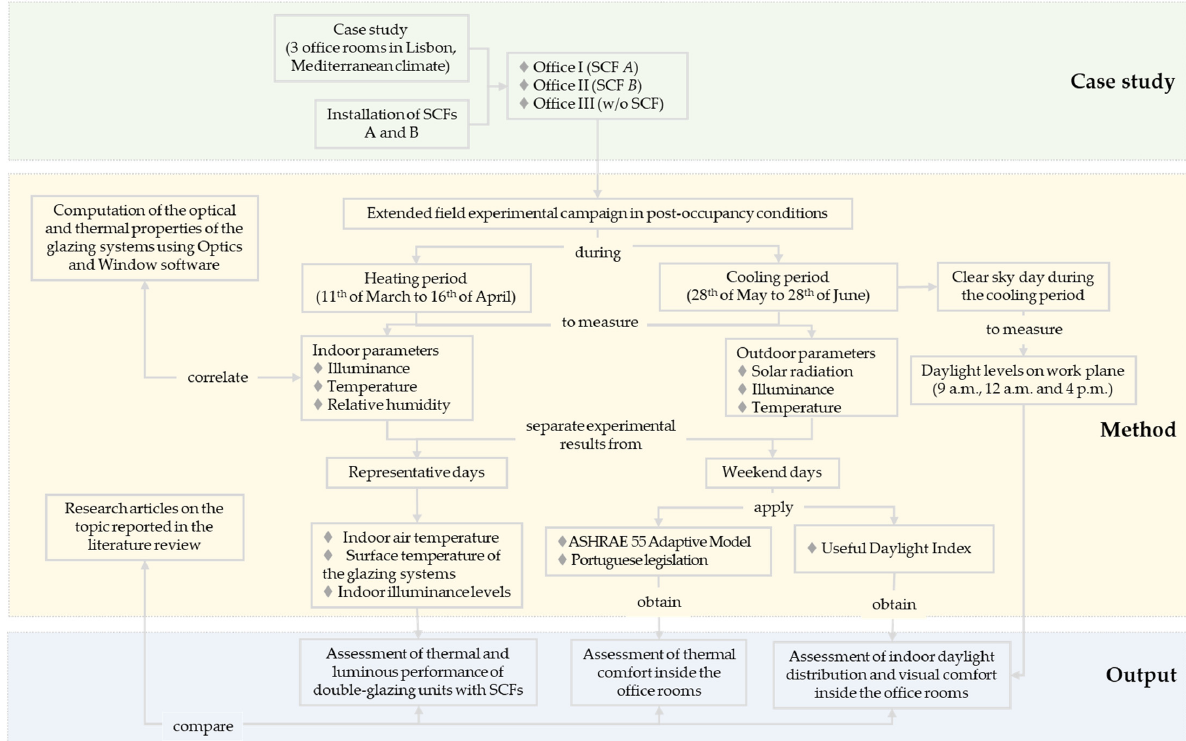
Figure 2. Block diagram with the proposed methodology.